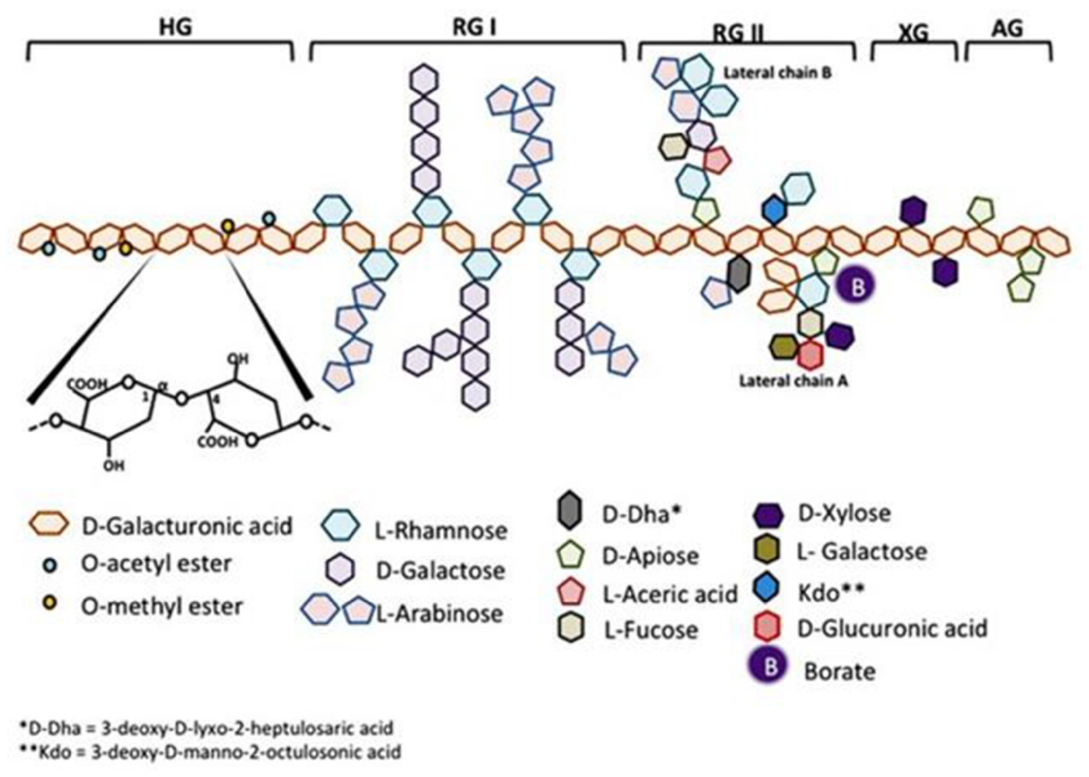
Figure 1. Schematic diagram of pectin structure [34]. Here, HG and AG refers to homogalacturonan and arabinogalactan.